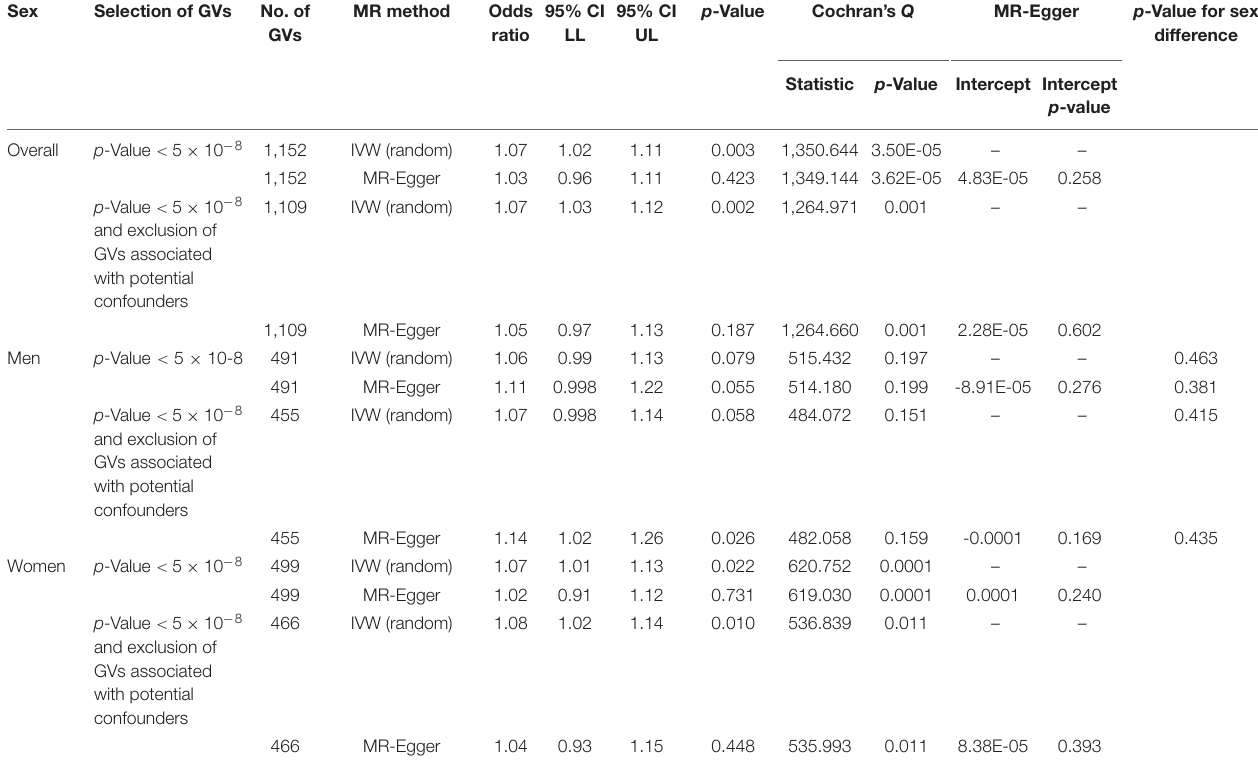
TABLE 2 | Multivariable Mendelian randomization association of basal metabolic rate with cancer adjusted for insulin-like growth factor 1. Sex Selection of